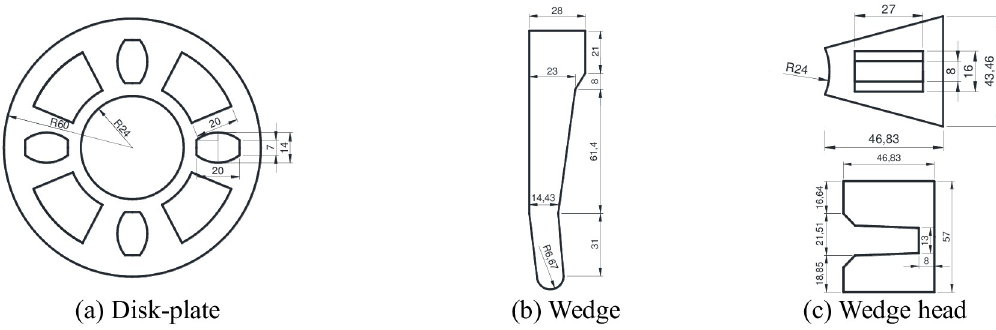
Fig 3. Geometrical size of the connection joints (unit: mm). (a) Disk-plate. (b) Wedge. (c) Wedge head.